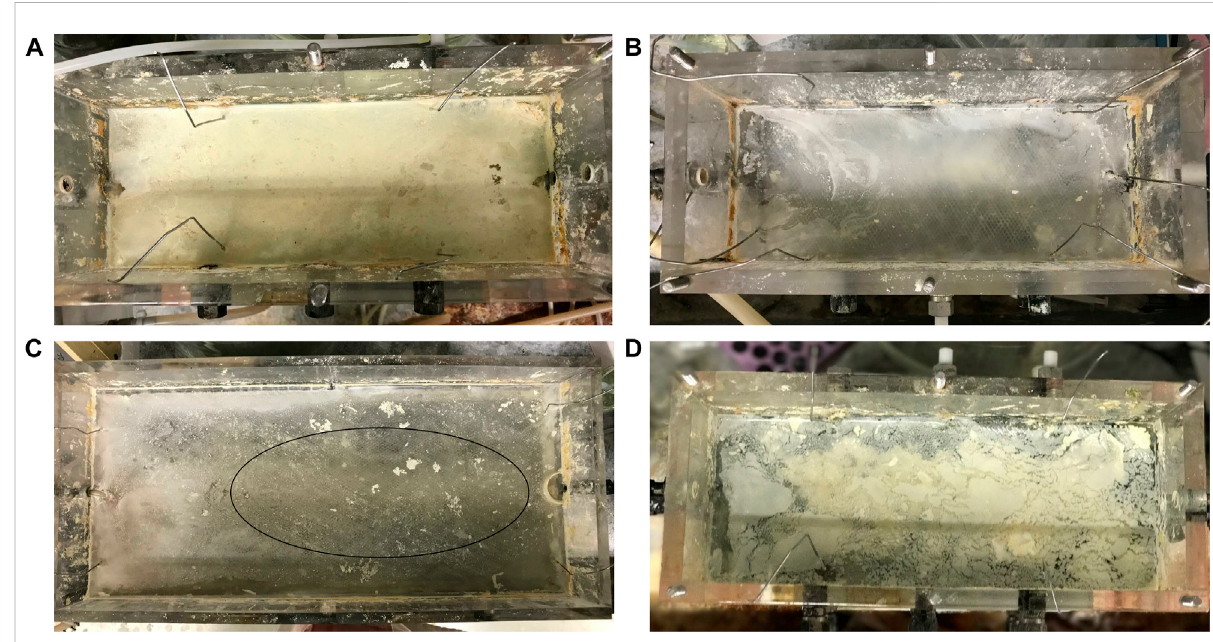
FIGURE 5 Photographs of the fl oating sulphur bio fi lm formation after disruption while operated at 2 day HRT showing the (A) 2 L lactate-fed reactor at 30 ° C after 2 days (well-developed bio fi lm), (B) 2 L lactate-fed reactor at 10 ° C after 2 days (poor formation), (C) 8 L lactate-fed reactor at 10 ° C after 2 days (circle indicates clear zone), and (D) 2 L acetate-fed reactor at 25 ° C after 5 days (premature